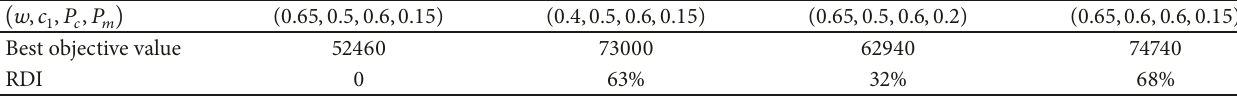
Table 4: The interaction of different parameter combinations.